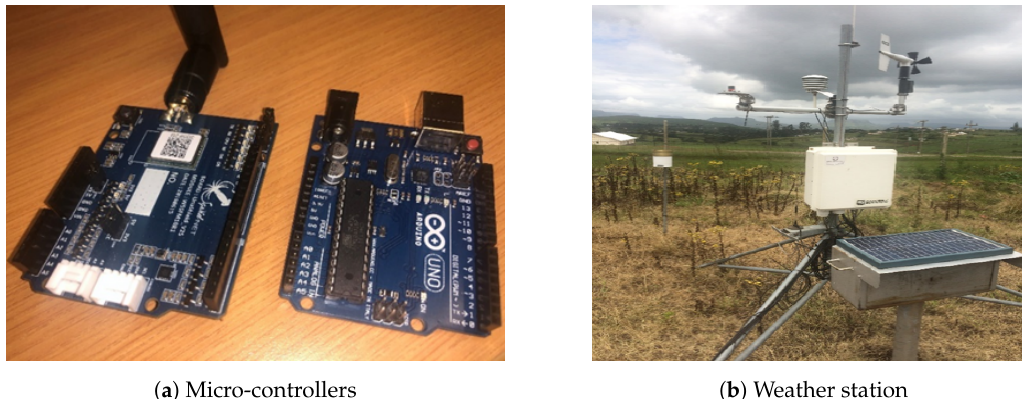
Figure 6. IoT devices and automated weather